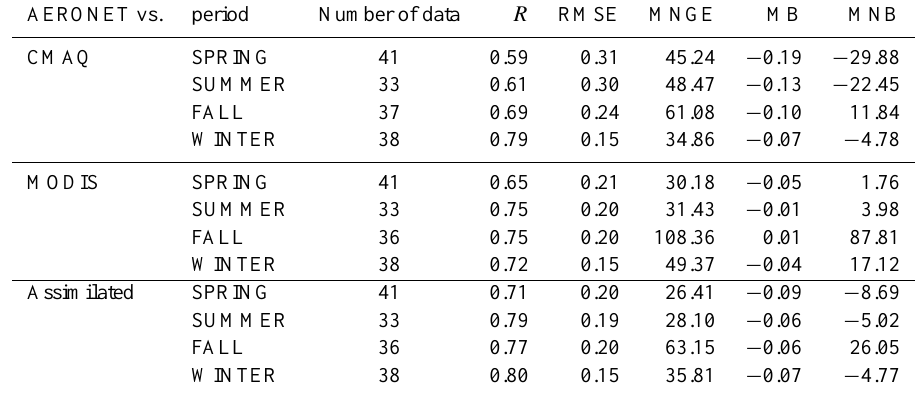
Table 8. Statistical values between the CMAQ-simulated, MODIS-retrieved, assimilated and AERONET AODs for all four seasons, 2006. AERONET vs.